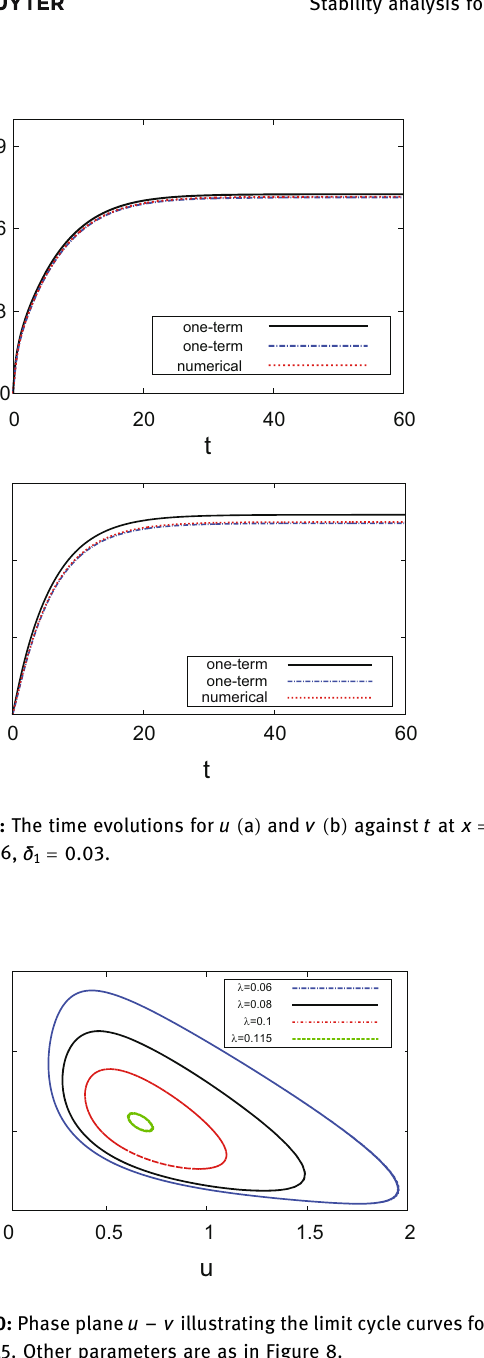
Figure 10 shows phase portraits of the concentrations at the center of the reactor for various choices of bifurcation parameter λ , illustrating the limit cycle curves. The fi gure presents the results of the two - term model at λ 0.06 = ( the blue closed curve ) , λ 0.08 = ( the black closed curve ) , λ 0.1 = ( the red closed curve ) , and λ 0.115 = ( the green closed curve ) , while other parameter values are the same as in Figure 8. These results demonstrate that the decreasing λ causes the expansion of the limit cycle, while increasing λ causes the lessening of the amplitude of the limit cycle, leading to a steady state scenario. Figure 11 shows the phase plane u v − representing the two - term limit cycle curves for di ff erent values of parameter δ 1 = 0.004, 0.06 and 0.1. Other parameters are fi xed as λ 0.06 =